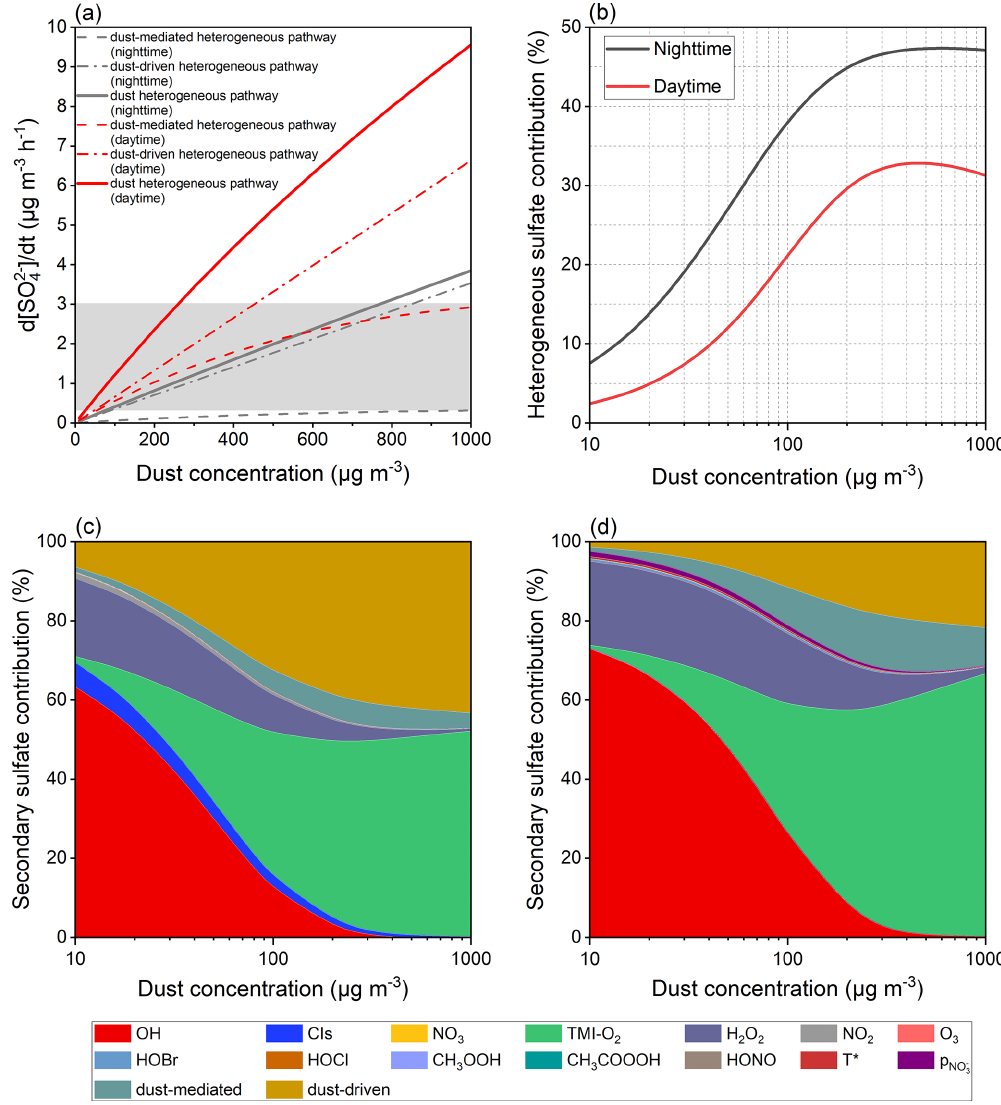
Figure 9. Sensitivity tests of the sulfate formation rate to dust concentration. (a) Sulfate formation rate of diverse dust-related heterogeneous pathways as a function of dust concentration. The grey area suggests that the missing sulfate formation rate ranges from 0.3 to 3µgm − 3 h − 1 as a reference (Cheng et al., 2016; T. Liu et al., 2021). (b) Heterogeneous sulfate proportion varying with dust concentration. Secondary sulfate contributions attributed to the studied oxidation pathways during (c) nighttime and (d)